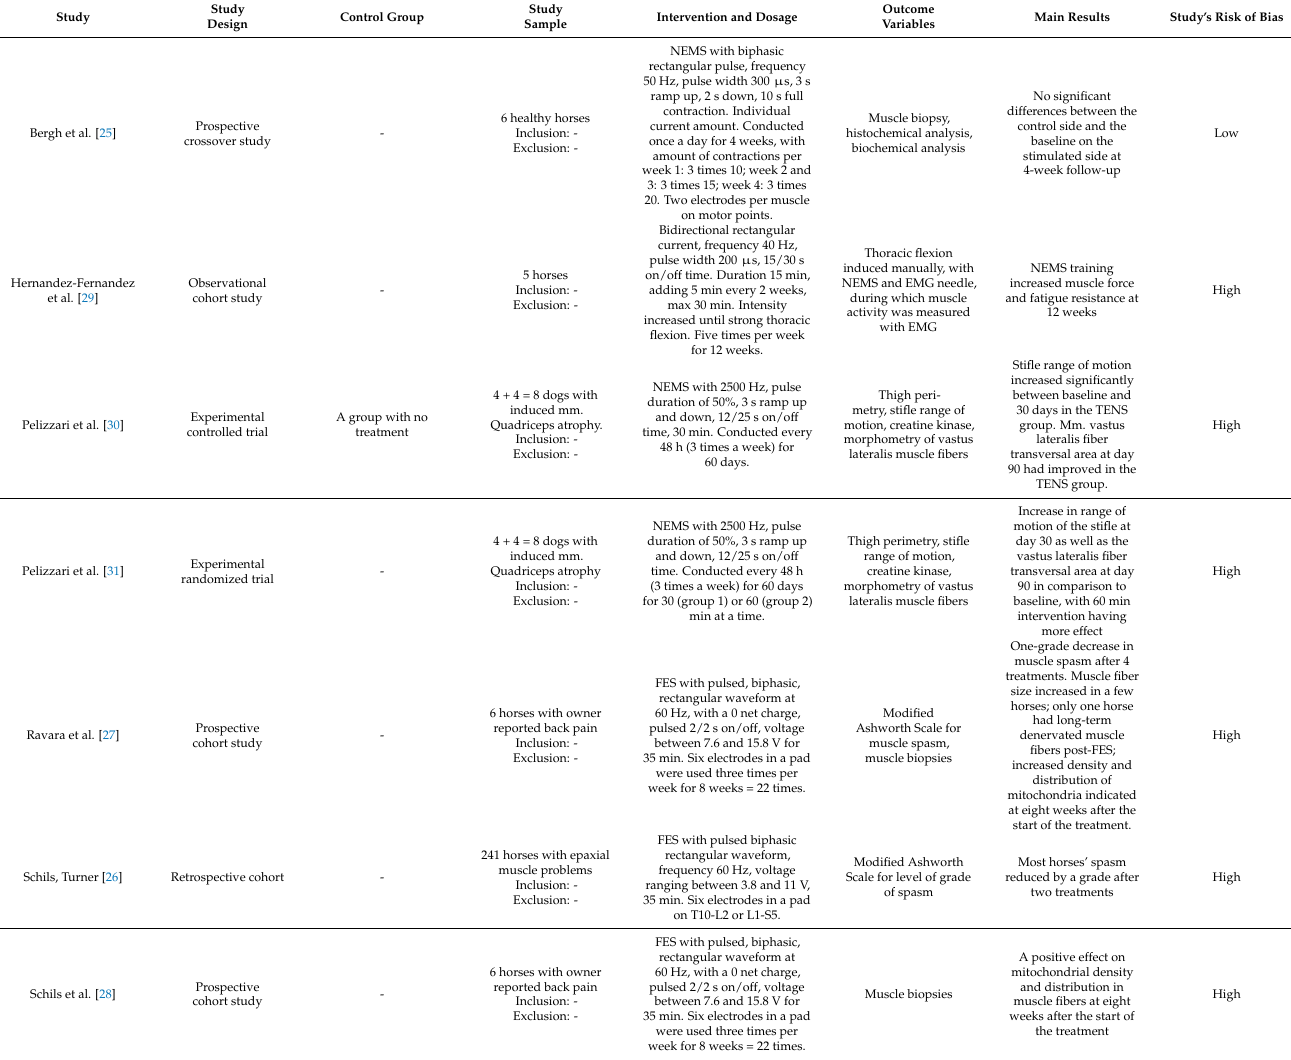
Table 3. Review of articles regarding neural electrical muscle